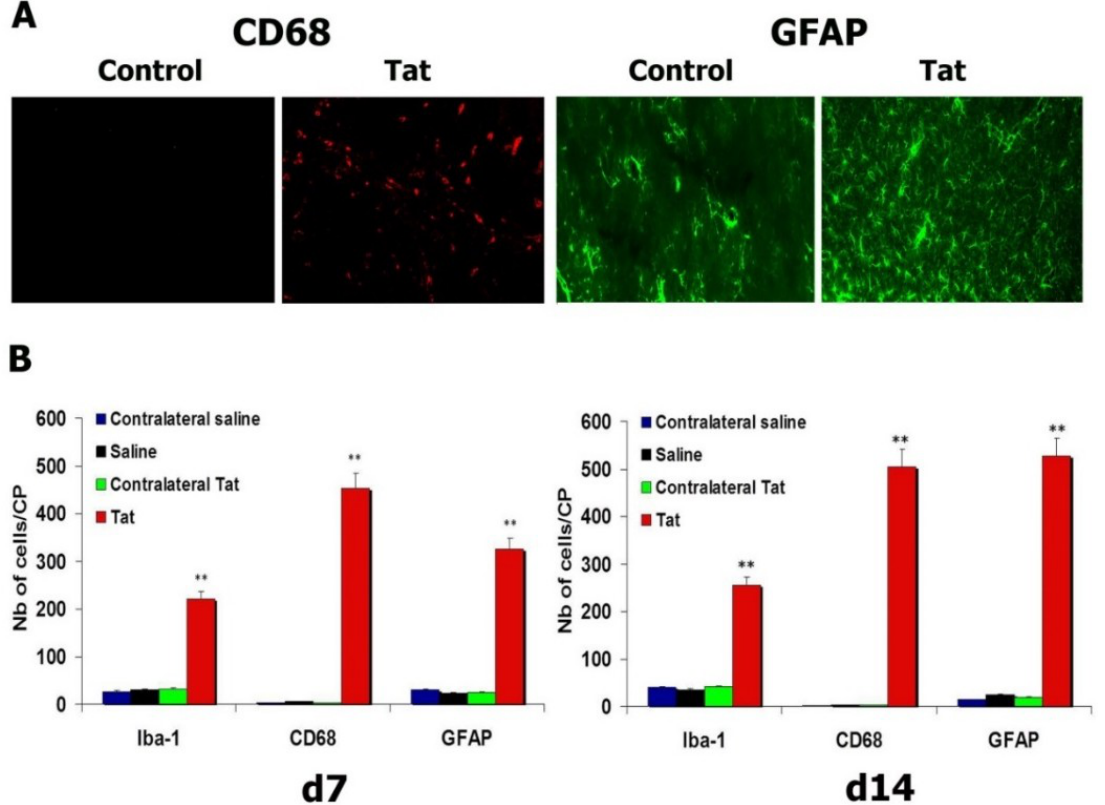
Figure 3. Injection of Tat in the caudate-putamen (CP) triggers neuroinflammation. ( A ) Activated (CD68-positive) microglial cells and proliferating astrocytes were observed in the CP of rats injected with Tat; ( B ) Graph showing an increase in the number of microglial cells (Iba-1 and activated CD68-positive cells) and astrocytes (GFAP-positive cells) persisting til d14. ** p <